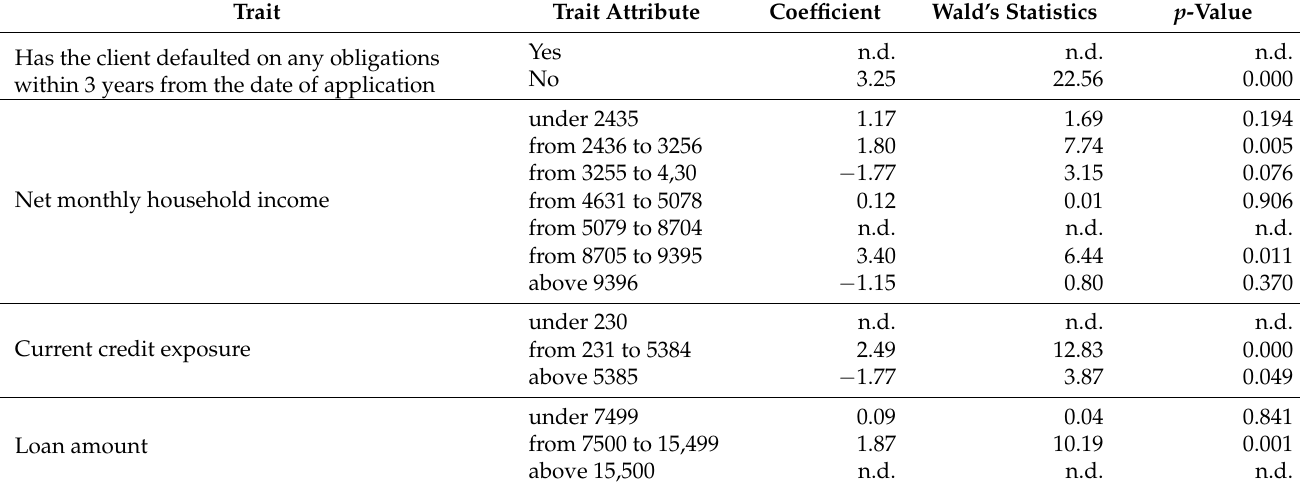
Table 7. Credit risk logit model for Bank